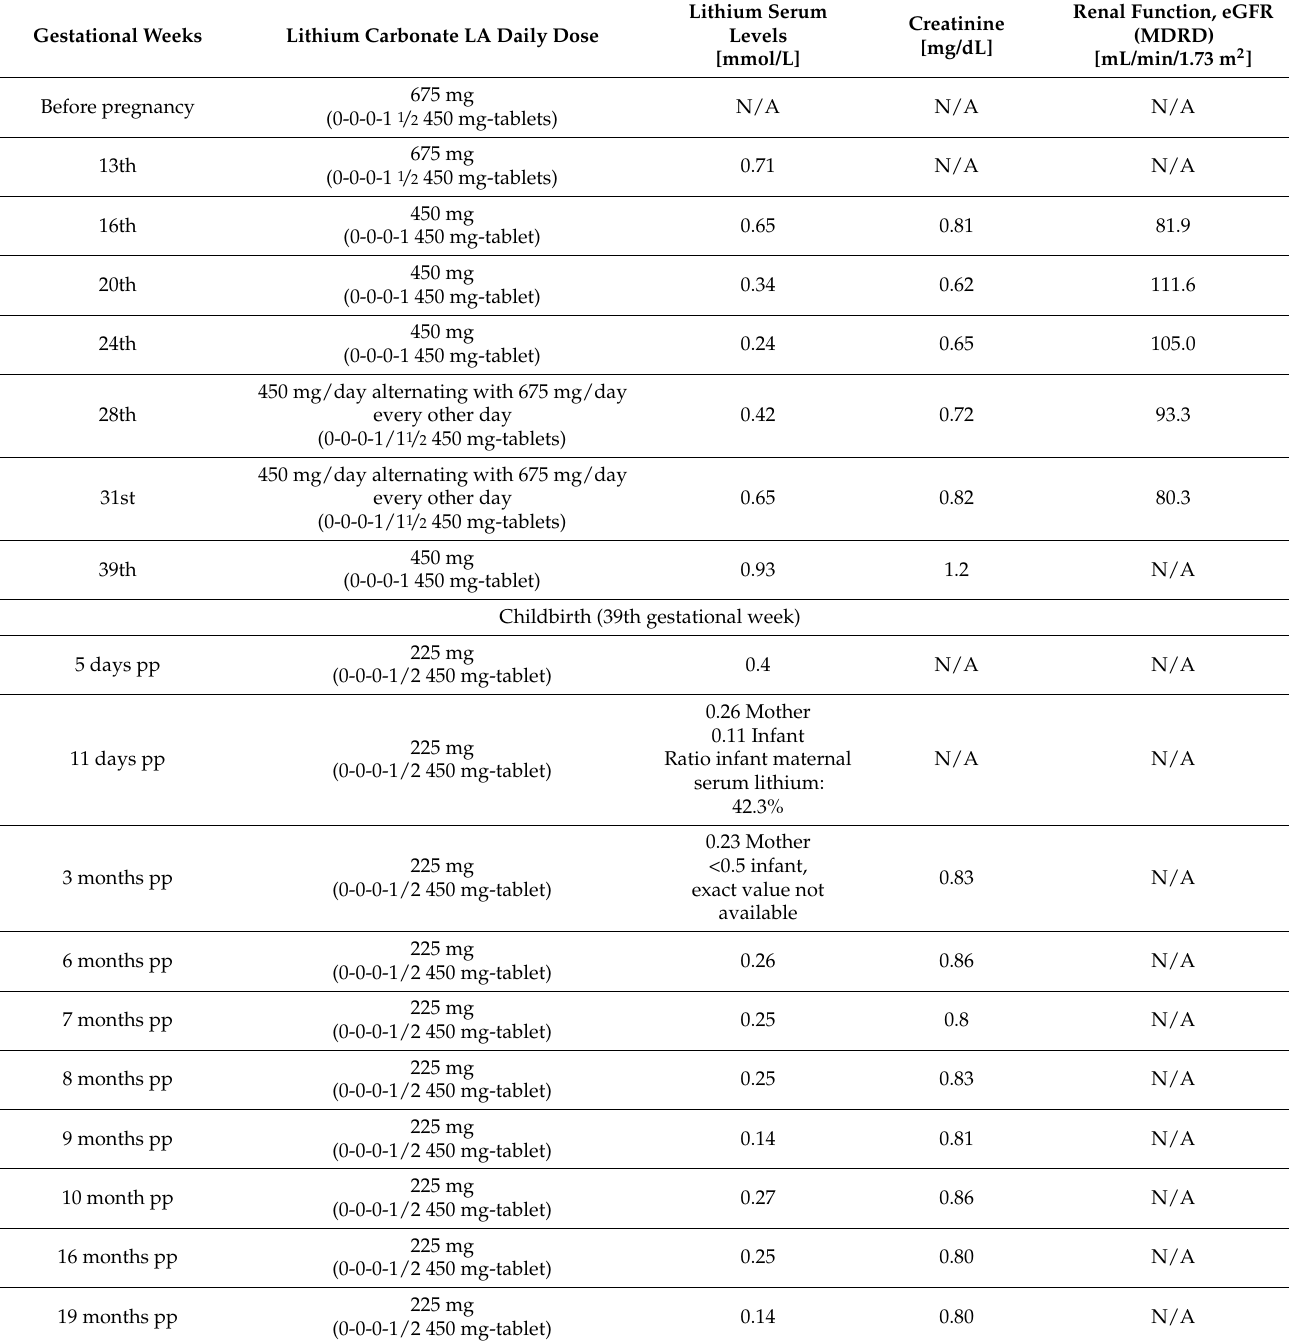
Table 3. Clinical data case